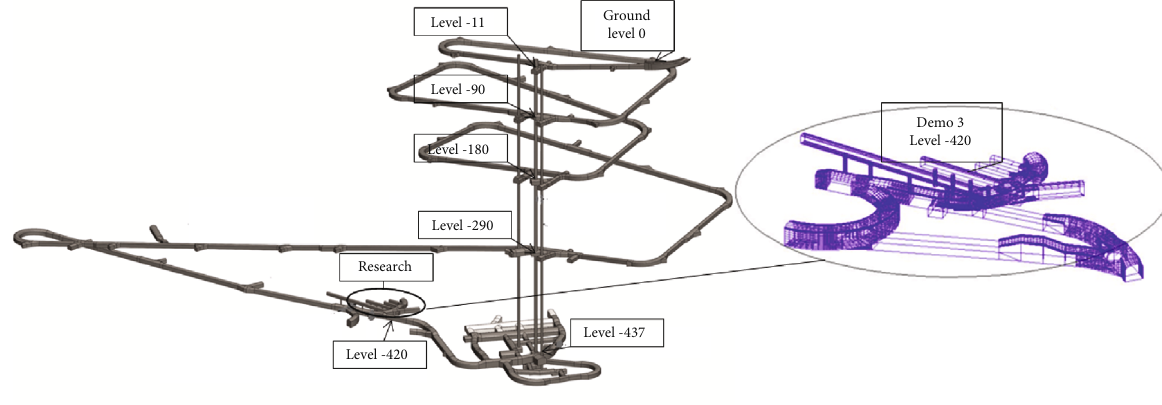
Figure 2: Study area at the ONKALO tunnel